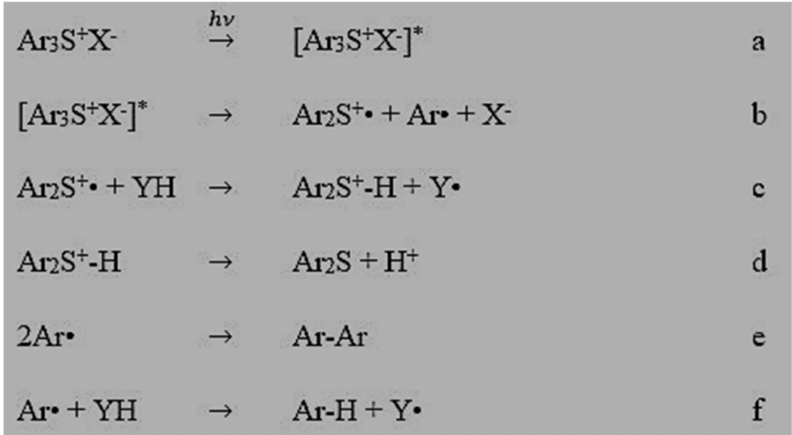
Figure 1. Cationic photocuring initiation mechanism. Reprinted (adapted) with permission from Crivello, J V (General Electric), “The Photoinitiated Cationic Polymerization of Epoxy Resins”. Copyright (1979) American Chemical